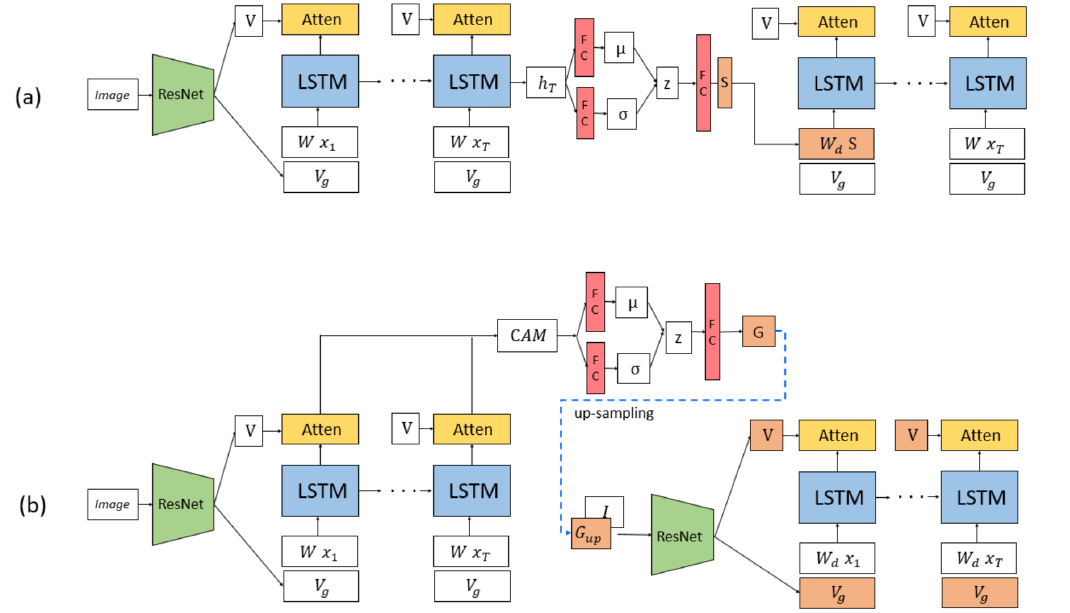
Figure 3. Illustration of variational autoencoder-based multiple image captioning models. ( a ) base model that projects sentence embedding to a latent distribution; ( b ) proposed model that projects CAM to a latent